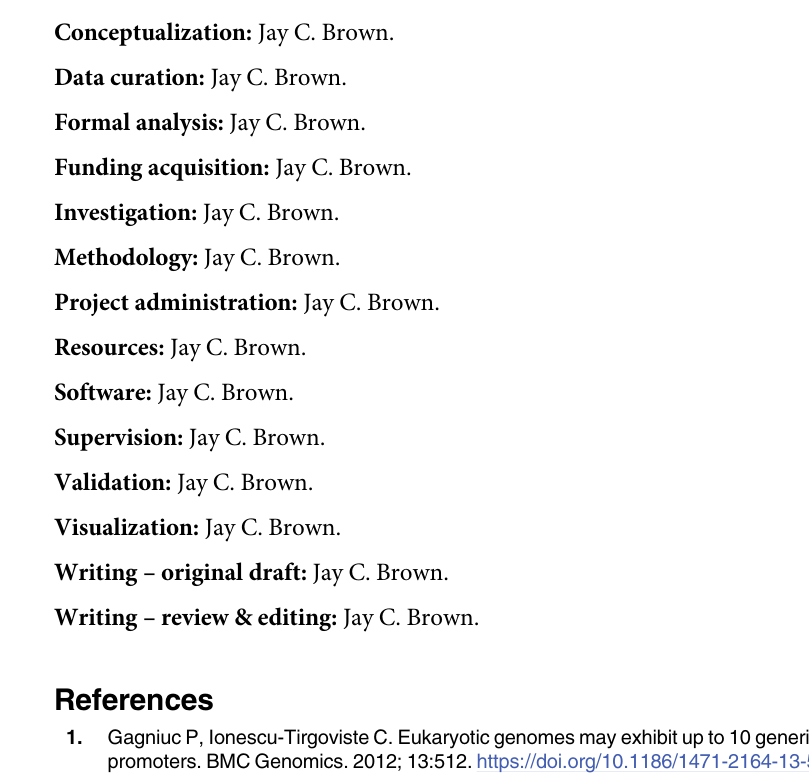
S1 Table. Database of human testis-specific genes. S2 Table. Human database testis-specific genes with a promoter and a transcription factor binding site near the transcription start